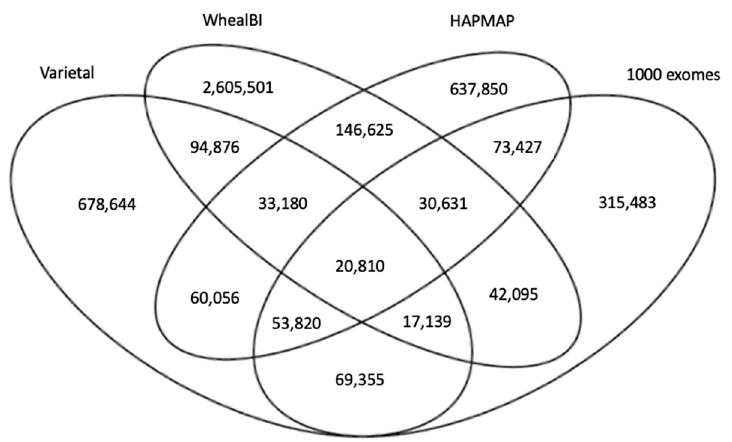
Figure 5. Venn diagram representing the consensus among four large-scale variation studies in wheat.